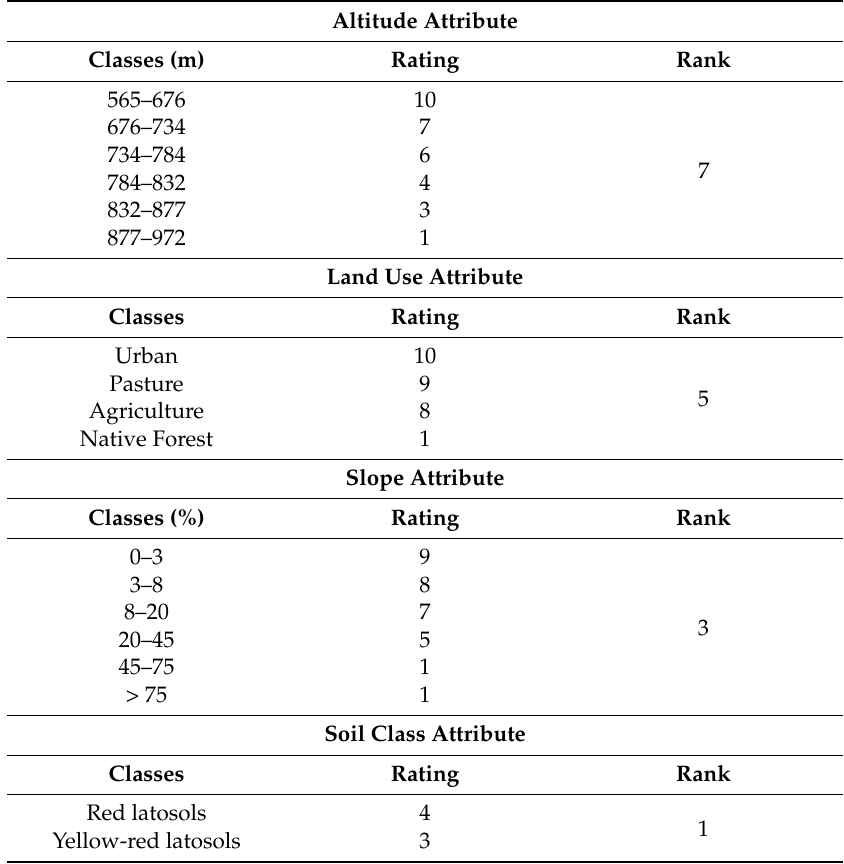
Table 1. Reclassification of environmental attributes according to their flood susceptibility. The source for the soil classes is